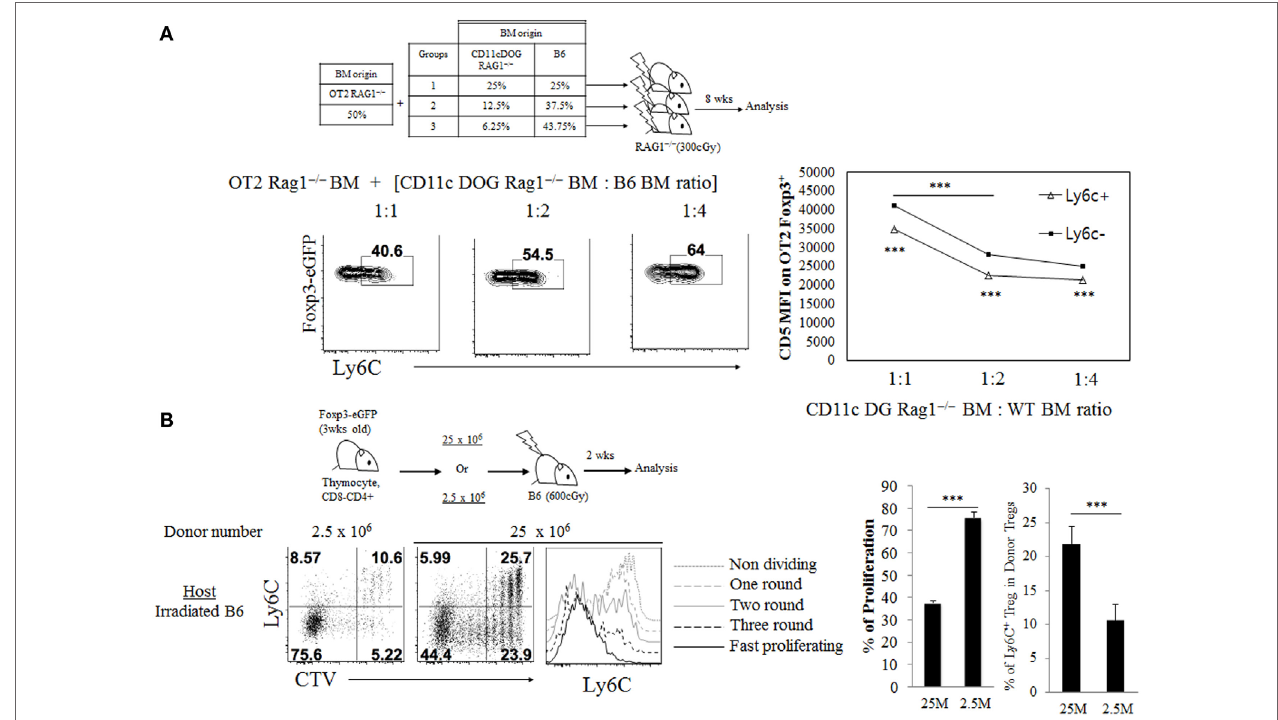
FigUre 2 | Impact of variable quantities of T cell receptor self-recognition on Treg N Ly6c + subset generation. (a) Bone marrow (BM) cells from CD11c.DOG Rag1 − / − were mixed with BM cells from wild-type WT Rag1 − / − mice at the indicated ratio and then this mixture of BM cells (50%) were mixed again with BM cells from OT-II Thy1.1 + Foxp3-eGFP Rag1 − / − mice (50%). These BM cell mixtures were injected into irradiated (300 cGy) Rag1 − / − hosts. At 8 weeks after BM cell transfer, cells from peripheral lymph node (PLN) were analyzed by flow cytometry for Ly6C expression and CD5. Shown are gated on Thy1.1 + CD4 + Foxp3 + cells. (B) Cell tracker violet (CTV) labeled, indicated number of CD8-depleted thymocytes from Thy1.1 + Foxp3-eGFP mice were injected into irradiated B6 hosts and then proliferation and Ly6C expression were analyzed on day 14 after transfer. Shown are proliferation and the Ly6C expression on donor Thy1.1 + Foxp3 + CD4 + cells in PLN. The data are representative of three experiments comprising four to five mice per group. * p < 0.05, ** p < 0.01, and *** p <